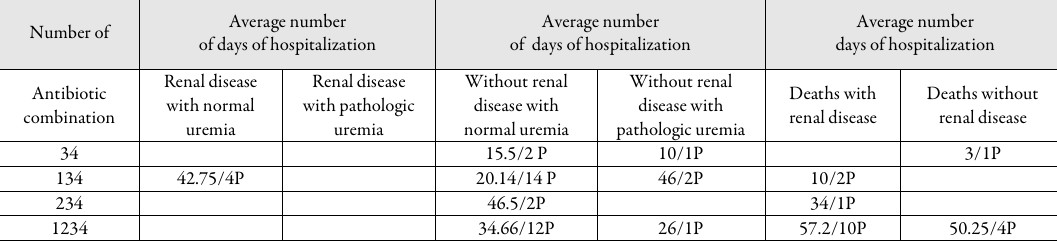
Table 10. Correlation between the average number of days of hospitalization and combinations of antibiotics considered